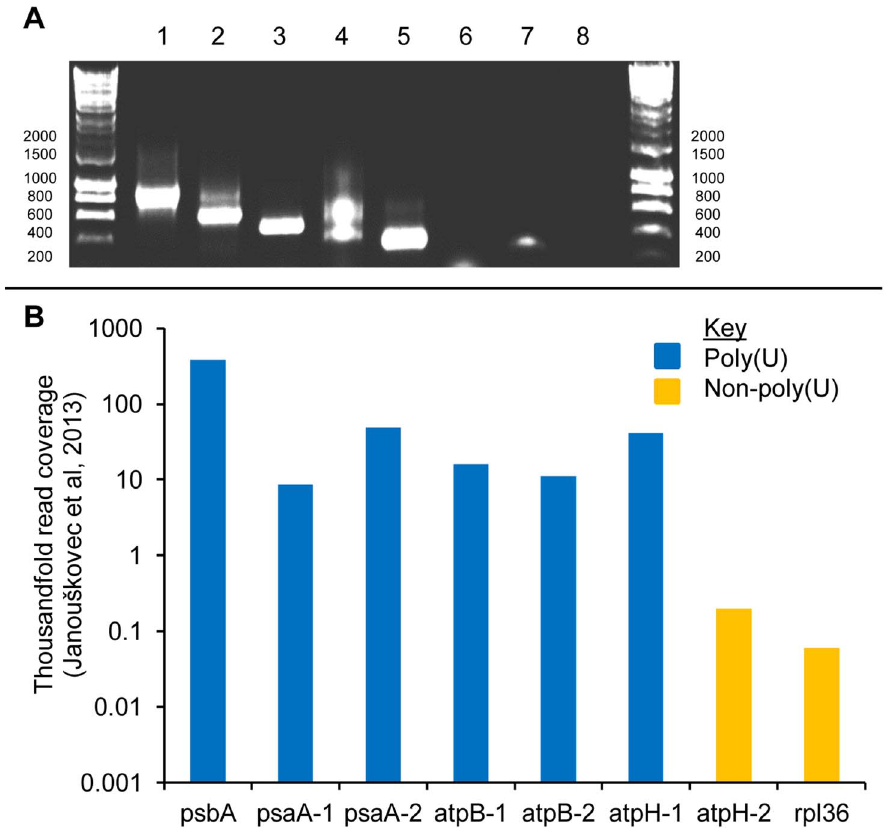
Figure 3. Polyuridylylation of duplicated photosynthesis gene transcripts in the Chromeravelia chloroplast. This figure shows the result of a series of RT-PCRs to characterise differential patterns of polyuridylylation for different copies of the psaA , atpB , and atpH genes in C. velia . Panel A: A gel photo showing oligo-d(A) RT-PCRs for (lanes 1–6) psaA-1 , psaA-2 , atpB-1 , atpB-2 , atpH-1 and atpH-2 . Poly(U) tails were found on transcripts of both psaA genes, as has been previously reported, both atpB genes, and atpH-1 , while atpH-2 was found not to be polyuridylylated. Lanes 7 shows the result of a gene-specific RT-PCR against atpH-2 , demonstrating that non-polyuridylylated atpH-2 transcripts are present. Lane 8 shows a template negative control. Panel B: Total abundance of transcripts for each gene in the quantitative read data obtained by Janousˇkovec et al. [32]. For reference, the most highly expressed ( psbA ) and least abundant (rpl36) transcripts encoding recognisable protein-coding function are also shown. Polyuridylylated transcripts are shaded in blue, and non-polyuridylylated transcripts in orange. While all six of the polyuridylylated transcripts shown are highly expressed, atpH-2 transcripts are found at much lower abundance, only slightly greater than those of rpl36 , indicating that the atpH-2 gene may be a